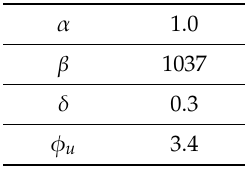
Table 7. Strand7 creep input values. 270